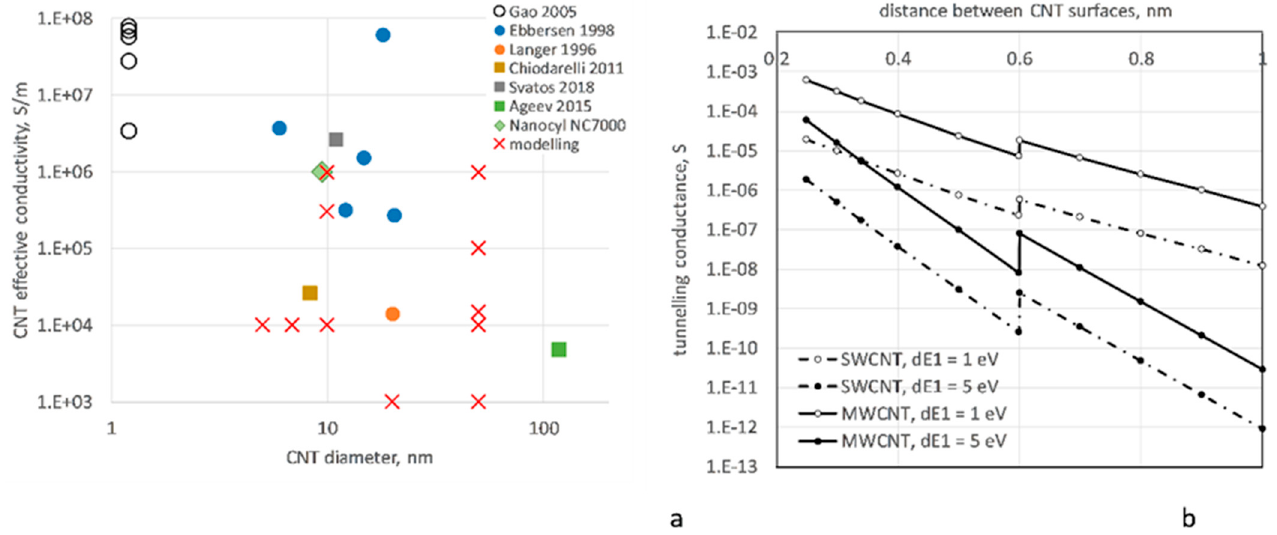
Figure 1. Uncertainty in electrical conductivity input data: ( a ) experimental data on intrinsic CNT conductivity, SWCNT (open symbols [46]), and MWCNT (filled symbols [44,47–51]); round points: experiments with single CNTs; squares: experiments with aligned CNTs; diamond: manufacturer’s datasheet; crosses: input data used in various modelling works; ( b ) tunneling conductance of a contact between two CNTs in function of the distance between them; results for SWCNTs and MWCNTs are calculated with Equations (2)–(4).